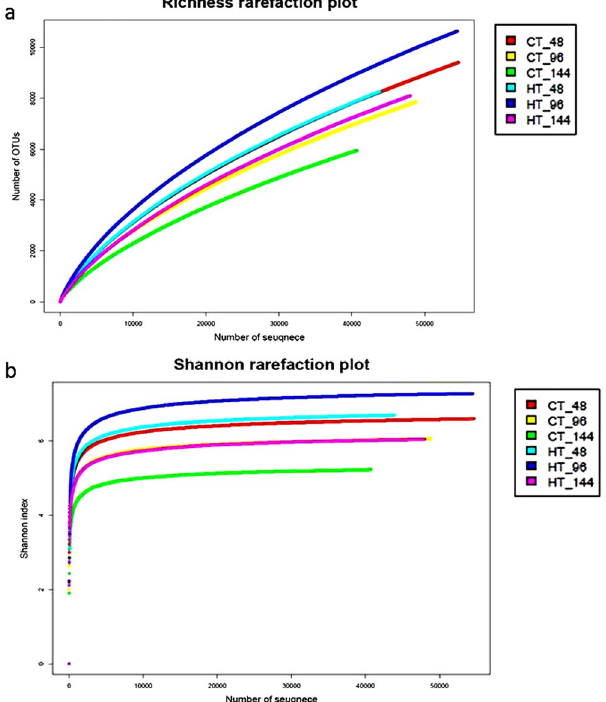
Figure 1. Richness rarefaction and Shannon index analysis of the different samples. CT-48 (96, 144) and HT-48 (96, 144) are samples mentioned in Table 1. ( a )Rarefaction curves of OTUs clustered at 97% sequence identity across difference samples. ( b ) Rarefaction curves of the Shannon index according to